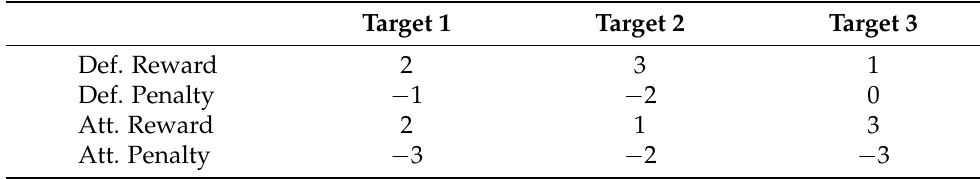
Table 1. The payoff matrix of a 3-target